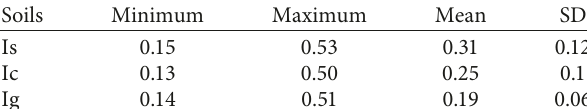
Table 3: Statistical parameters of the indices of three soils.